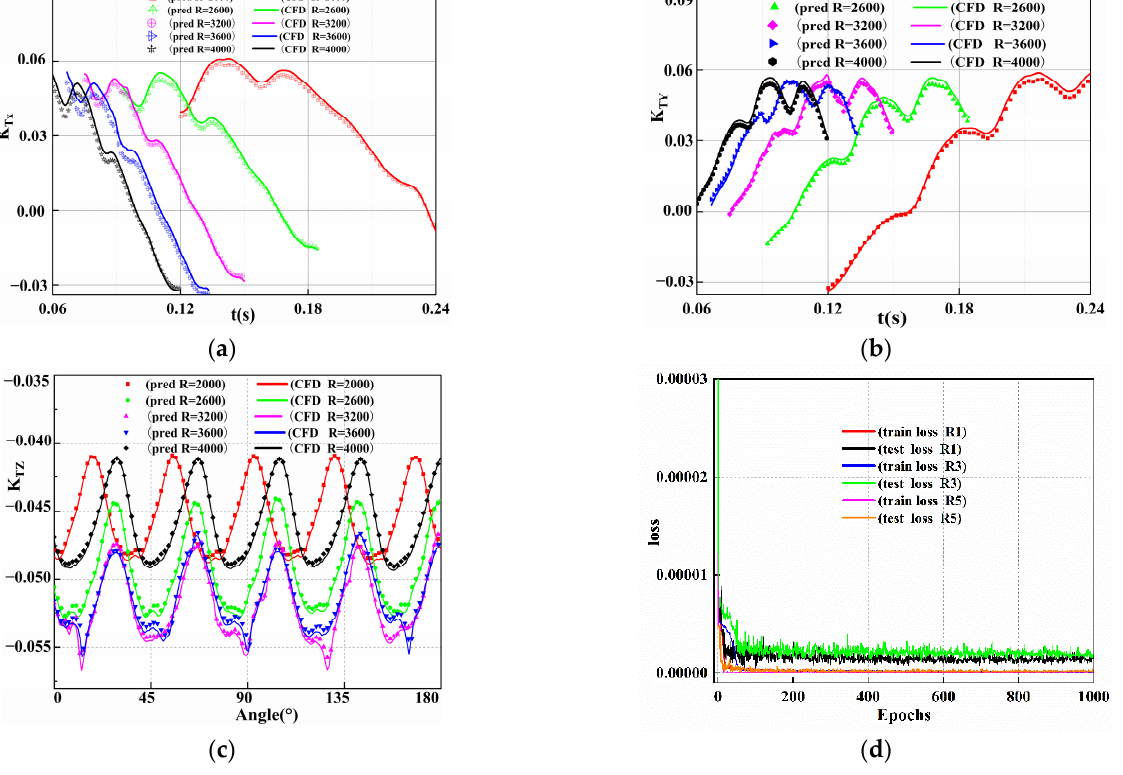
Figure 15. Difference of the bearing force between the predicted value and CFD value. ( a ) Difference of TX K at different rotating speeds. ( b ) Difference of TY K at different rotating speeds. ( c ) Difference of TZ K at different rotating speeds. ( d ) Training and testing losses.